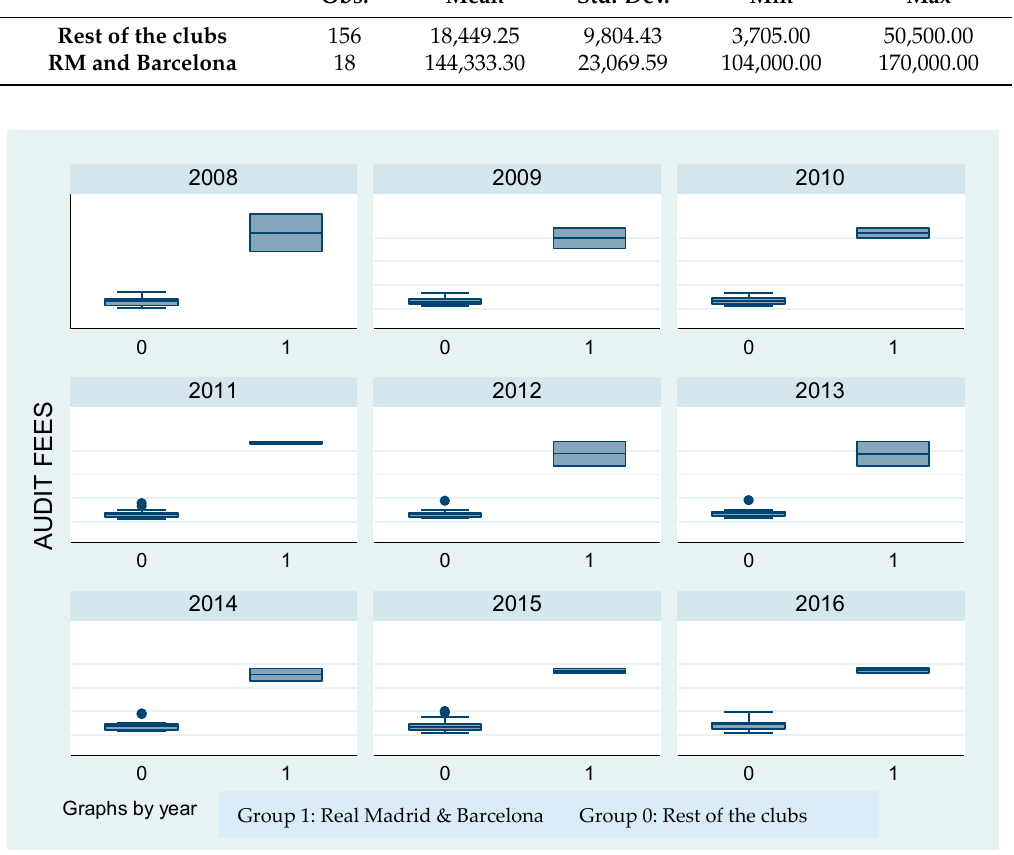
Figure 1. Differences, on average, between the Real Madrid and Barcelona audit fees and those of the rest of the clubs.